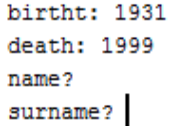
Figure 6. Python console is showing automatic extracted birth and death year information and seeking input from users for name and surname.